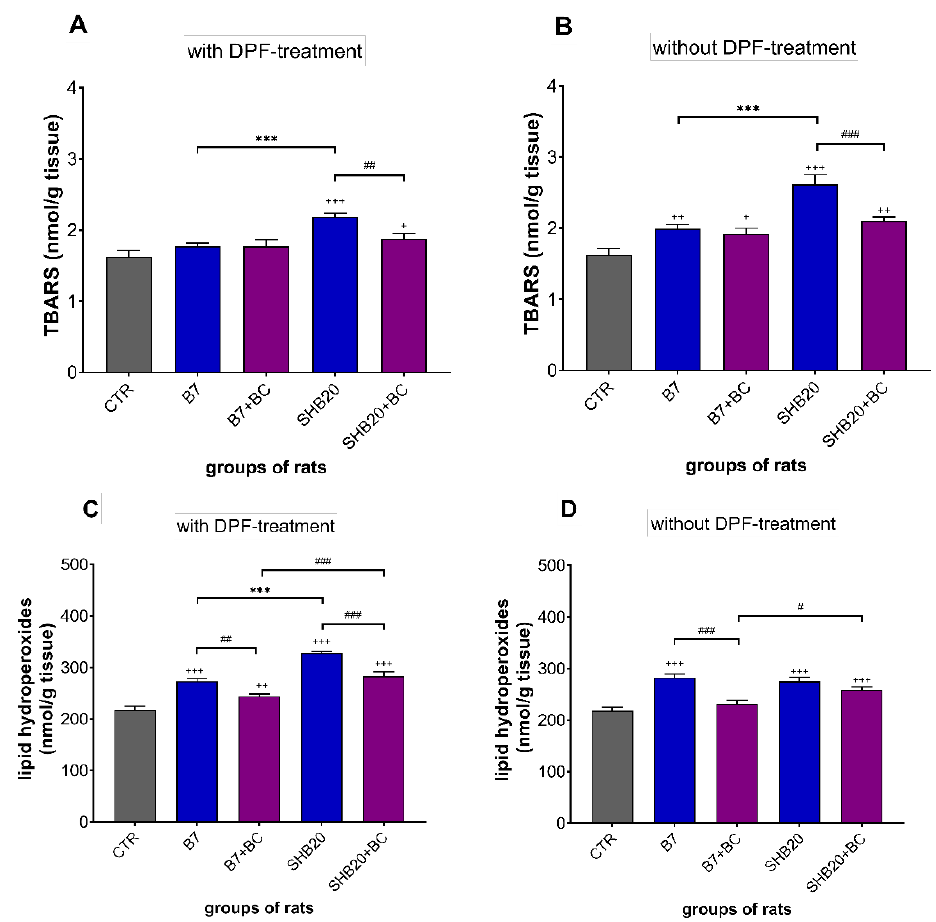
Figure 5. The concentration of thiobarbituric acid reactive substances (TBARS) ( A , B ) and lipid hydroperoxides (LOOHs) ( C , D ) in the testes of rats exposed to DEE from B7 or SHB20 biofuels with and without DPF-treatment and with or without blackcurrant pomace supplementation (BC) for 28 days. Data are expressed as mean ± SEM. # — significant difference between normal and blackcurrant pomace supplemented diet, # p < 0.05; ## p < 0.01; ### p < 0.001; * — Statistically significant difference between B7 and SHB20 DEE, *** p < 0.001; + — Statistically significant difference from the control group (CTR), + p < 0.05; ++ p < 0.01; +++ p < 0.001, one-way ANOVA with Duncan’s post hoc test.